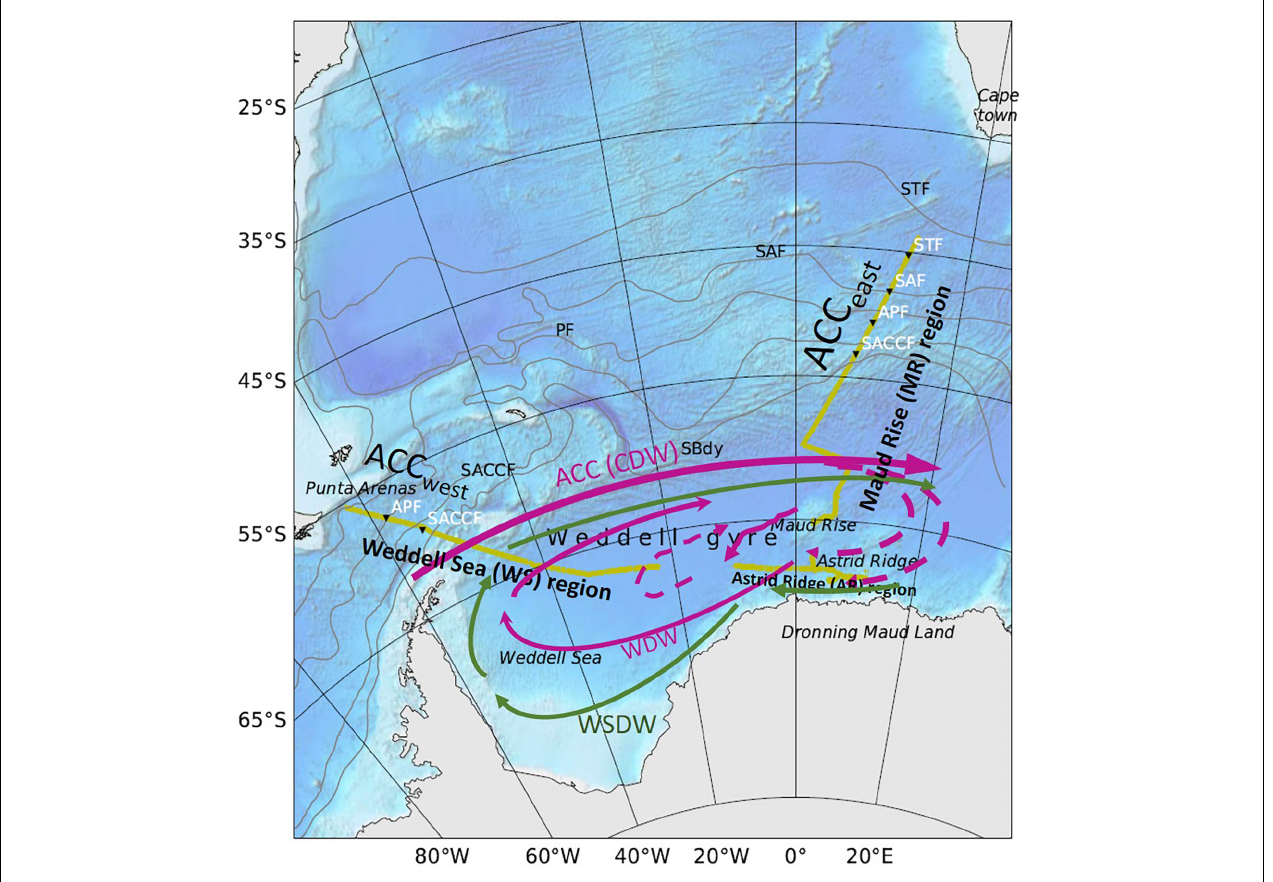
FIGURE 1 | Study transect (yellow) with topography and trajectories of warm deep water (WDW, cyan), and Weddell Sea deep water (WSDW, green) modified after Hellmer et al. (2016). Gray lines: subtropical front (STF), subantarctic front (SAF), polar front (PF), South Antarctic circumpolar front (SACCF), and southern boundary (SBdy) are frontal positions as defined by Orsi et al. (1995). Solid black triangles are fronts identified along the study transect from the hydrographic data for this